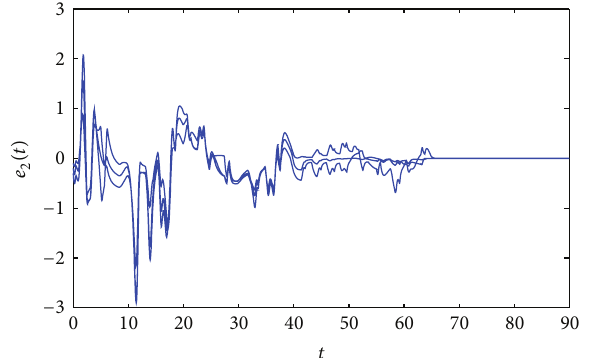
Figure 3: Synchronization errors of system (25) and system (27).